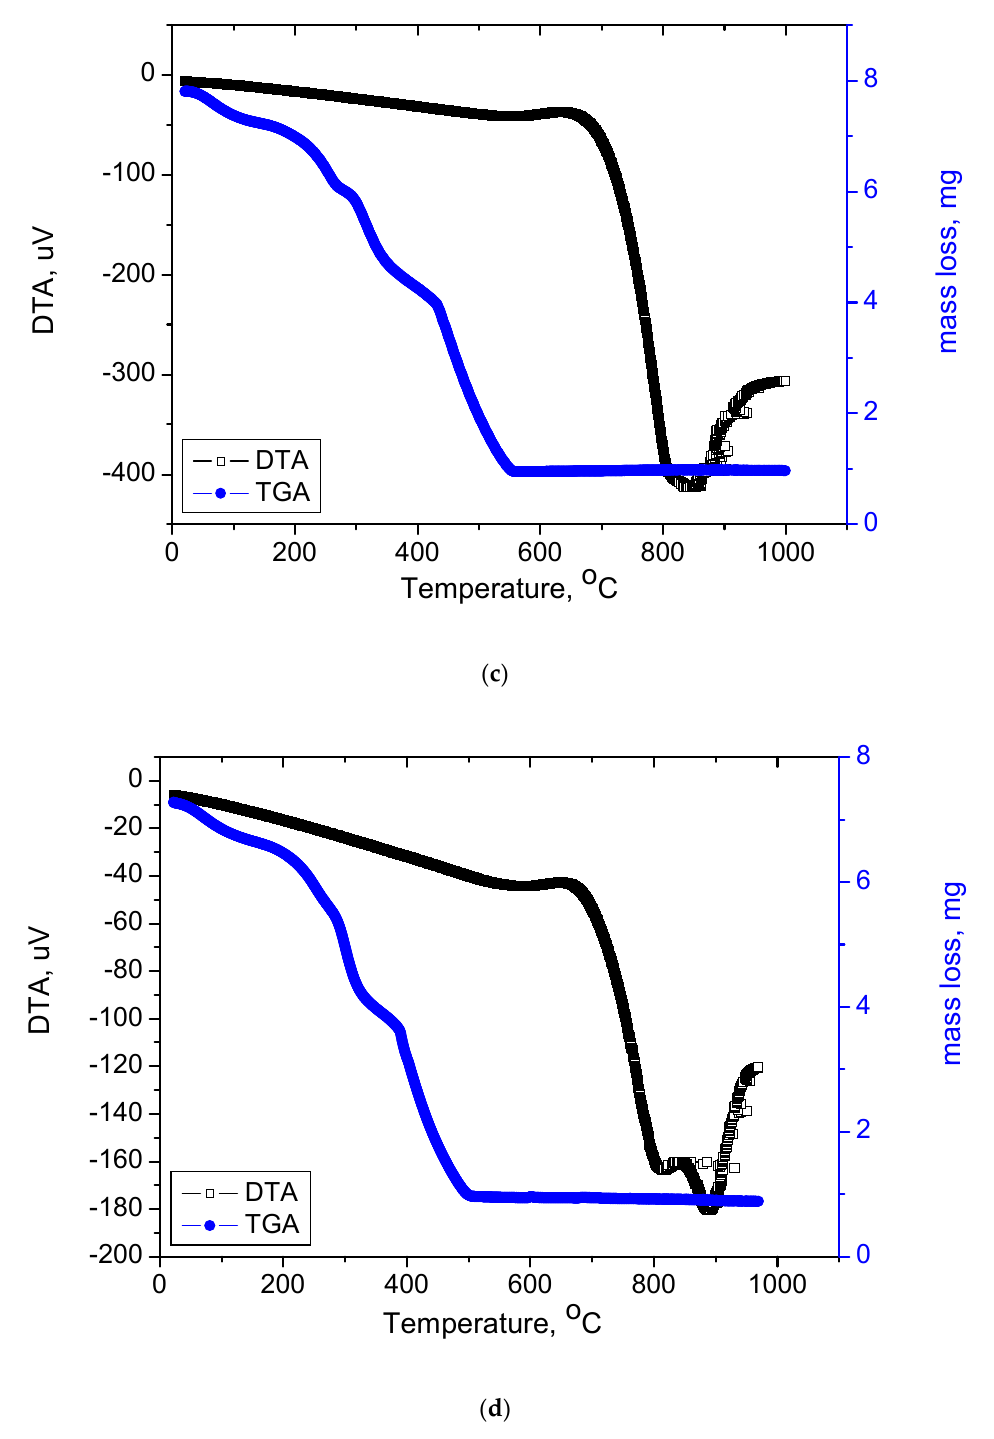
Figure 8. ( a ) TGA and DTA curves of free OFL drug; ( b ) TGA and DTA curves of Complex1 ; ( c )TGA and DTA curves of Complex 2 ; ( d )TGA and DTA curves of Complex 3 and DTA curves of Complex 2 ; ( d )TGA and DTA curves of Complex 3 .